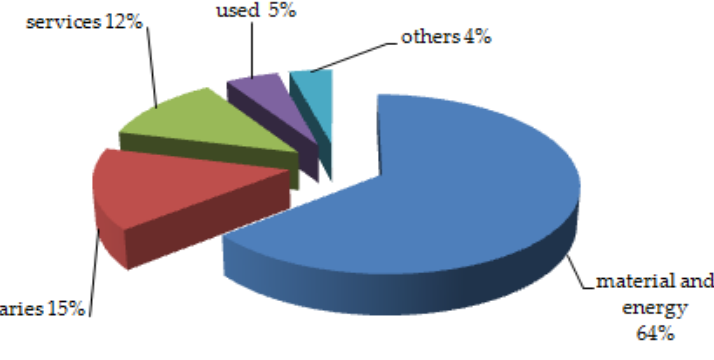
Figure 3. The share of energy costs in the steel production process.